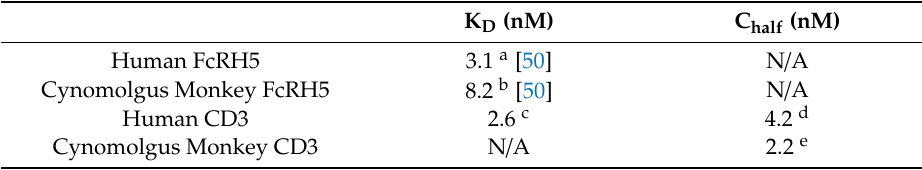
a Analyzed in human SVT2 cell lines expressing FcRH5 at room temperature; b analyzed in cynomolgus monkey SVT2 cell lines expressing FcRH5 at room temperature; c analyzed in human Jurkat cell lines expressing CD3 at room temperature; d analyzed in human PBMC cells expressing CD3 at 4 ◦ C; e analyzed in cynomolgus monkey PBMC cells expressing CD3 at 4 ◦ C. K D = equilibrium dissociation constant; C half = concentration at half maximal response. The data were averaged from three independent experimental